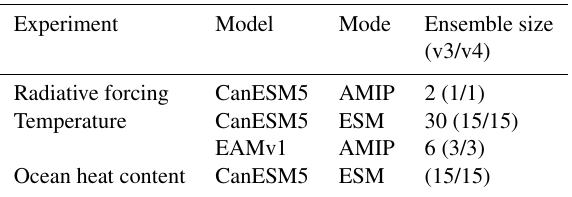
Table 1. Models and model configurations used in this